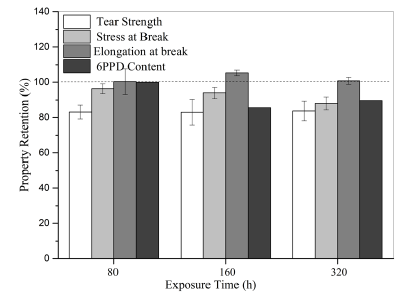
Figure 13. Retention of mechanical properties aged in the ozone chamber of the compositions comprising 2.5 phr of 6PPD and 1.0 phr of TMQ.